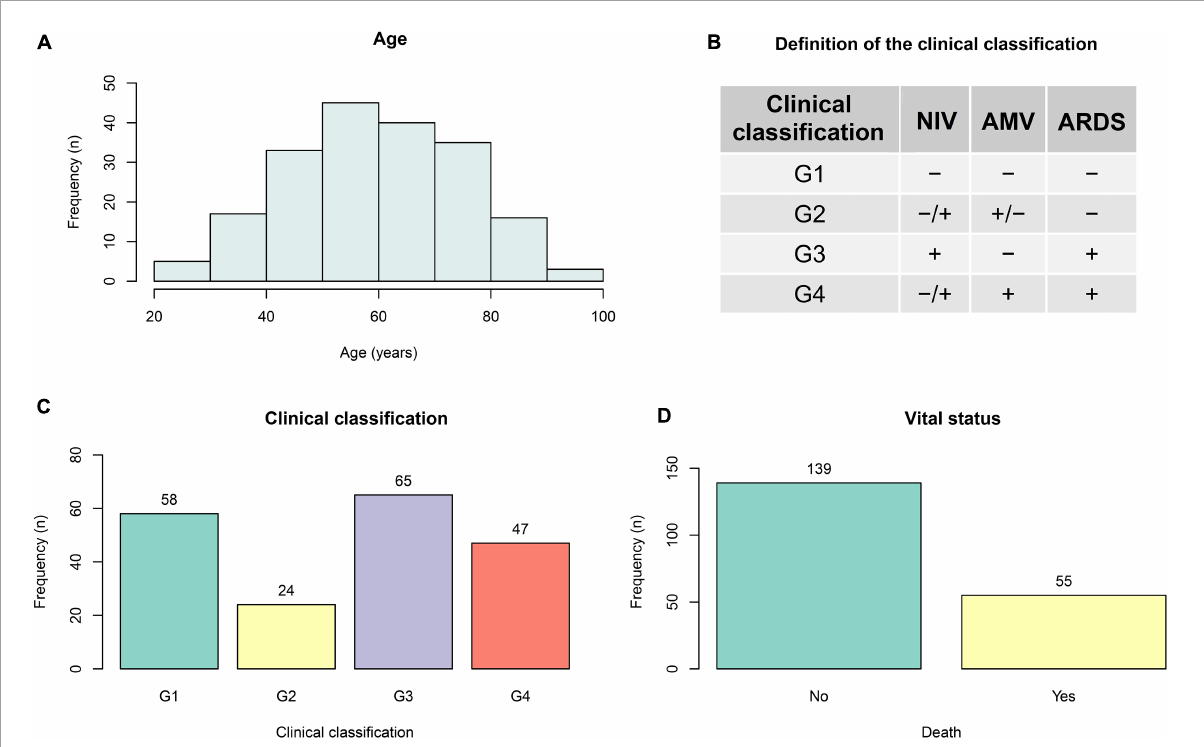
FIGURE1 General information. Data from 194 confirmed cases of hospitalized COVID-19 patients from 25 to 97 years (A) old were collected, including 55 deaths (D) during the time of hospitalization. A clinical classification (G1–G4) was created according to diagnosis of acute respiratory distress syndrome (ARDS), as well as usage of assisted mechanical ventilation (AMV) and/or non-invasive ventilation (NIV) (B,C)